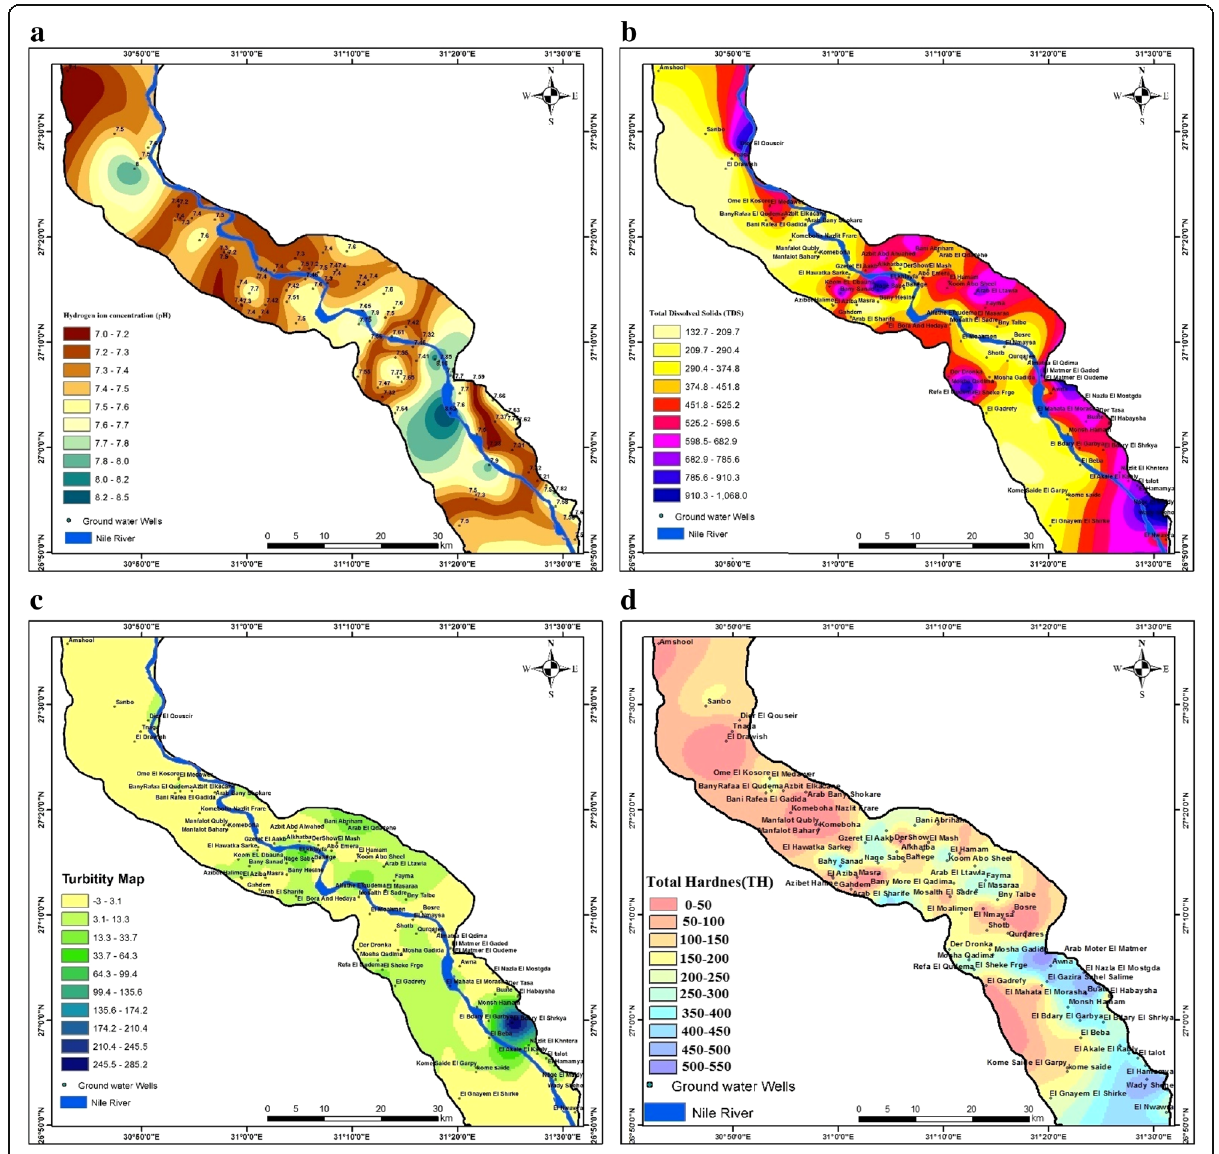
Fig. 6 Iso-concentration maps showing spatial variation in a pH, b TDS, c turbidity, and d TH in the study